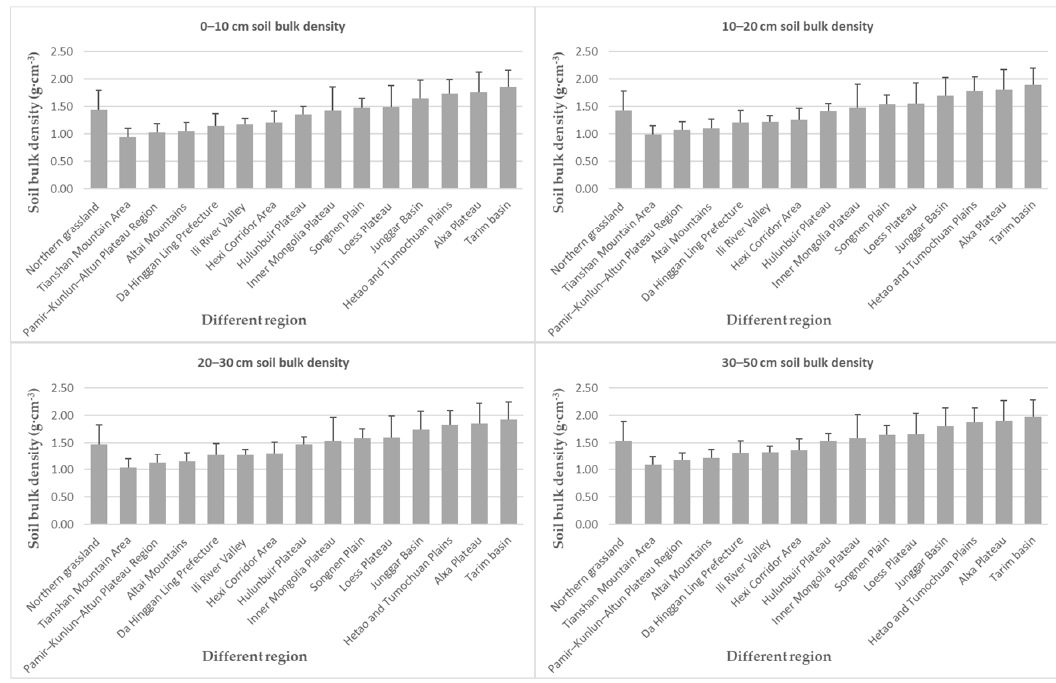
Figure 6. Stratified soil bulk density in different depths and geographical regions. Mean +1SD. Table 2. Statistical analysis in different geographical regions.